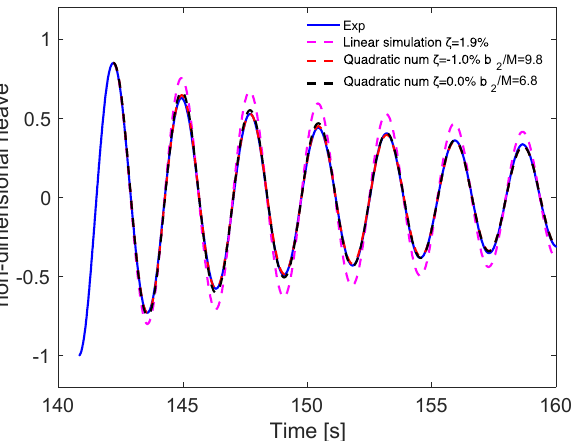
Figure 9. Time series fitted by different damping coefficients for an experimental heave free decay test in still water.